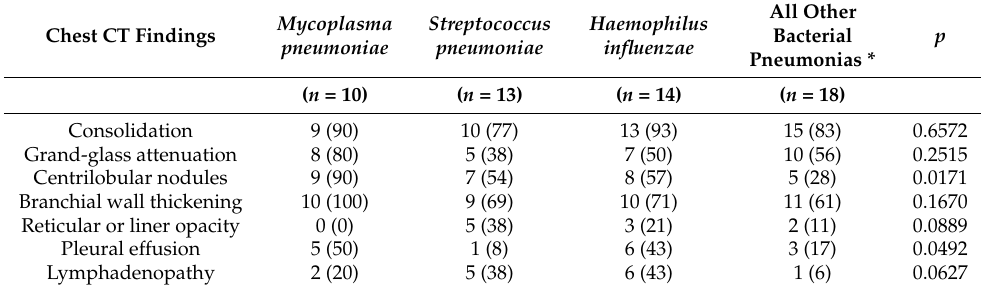
Table 2. Chest CT findings of the 55